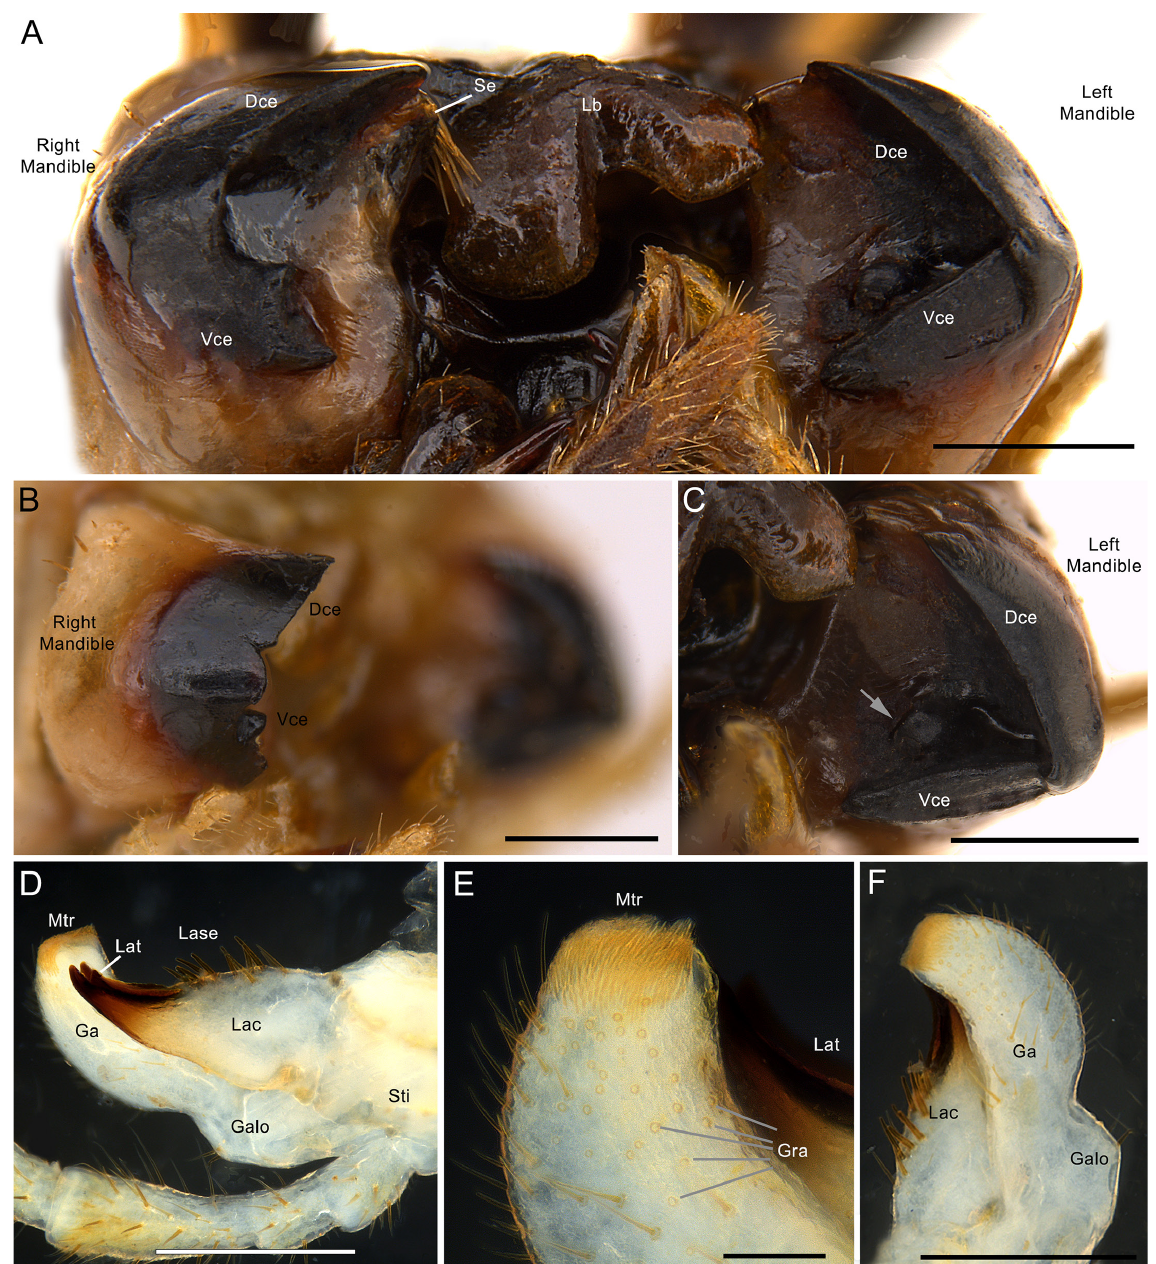
Fig. 4. Mouthparts of Arumatia dubia (Caudell, 1904) gen. et comb. nov., adult ♀♀ from stock from Ibaté, São Paulo, Brazil. A . Both mandibles spread showing internal view. B . Right mandible in anterior view. C . Left mandible, internal view, showing mesal protuberance (arrow). D . Right maxilla, ventral (external) view. E . Detail of left maxilla, dorsal (internal) view. F . Left maxilla, dorsal (internal) view. Abbreviations: Dce = dorsal cutting edge; Ga = galea; Galo = galealobulus; Gra = granules; Lac = lacinia; Lase = lacinial setae; Lat = lacinial teeth; Lb = labrum; Mtr = microtrichia; Se = setae; Sti = stipes; Vce = ventral cutting edge. Scale bars: A–D, F = 0.5 mm; E = 0.1